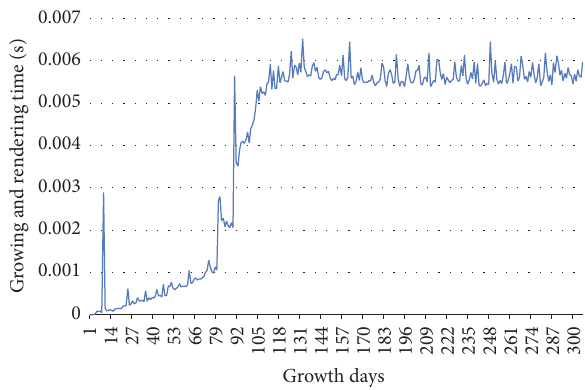
Figure 16: The time statistics in a growth cycle of a tomato plant in our TomatoVis system. The longest growth cycle for tomato is nearly 304 days in the greenhouse. In most cases, the growth cycle for tomatoesis4–6months.Inanycase,thegrowingandrenderingtime for one plant in our system is less than 0.007 seconds-per-frame, which means the growth process can be displayed in real time.